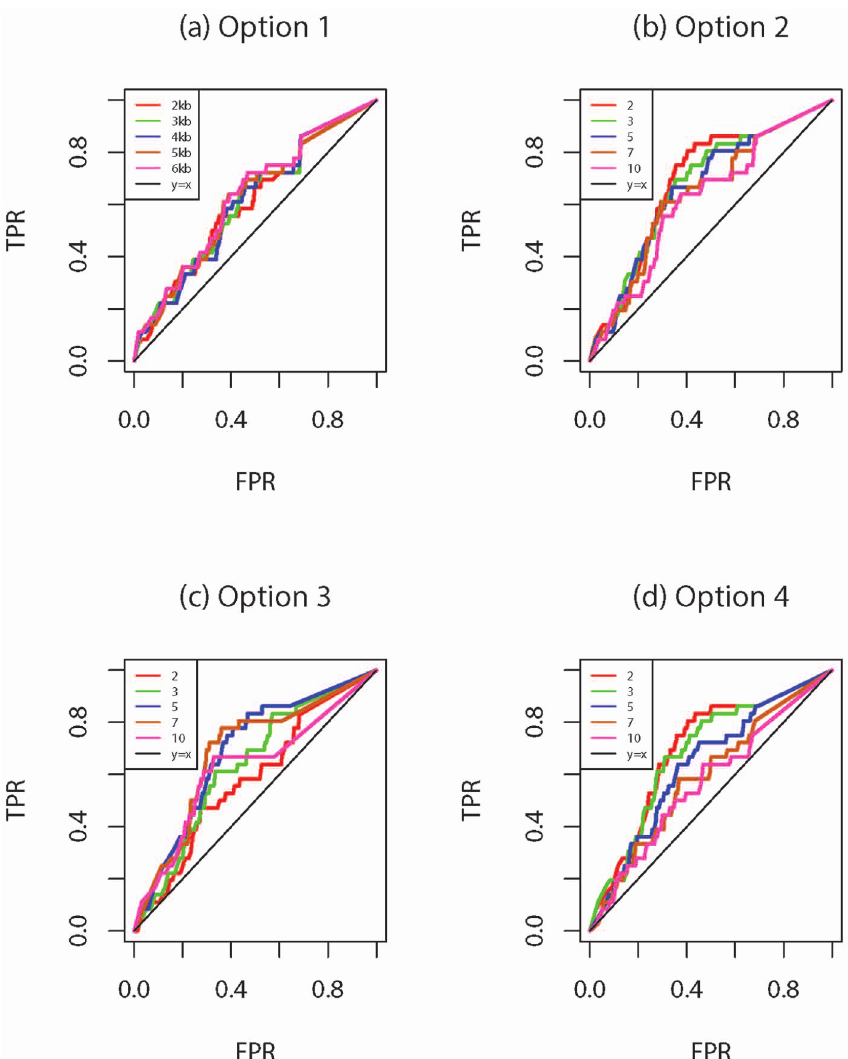
Figure 2. rbFBAT results using different blocking options: (a) Option 1 with block size 2, 3, 4, 5, or 6 kb; (b) Option 2 with number of blocks 2, 3, 5, 7, or 10; (c) Option 3 with blocks including 2, 3, 5, 7, or 10 SNVs; (b) Option 4 with number of blocks 2, 3, 5, 7, or 10.